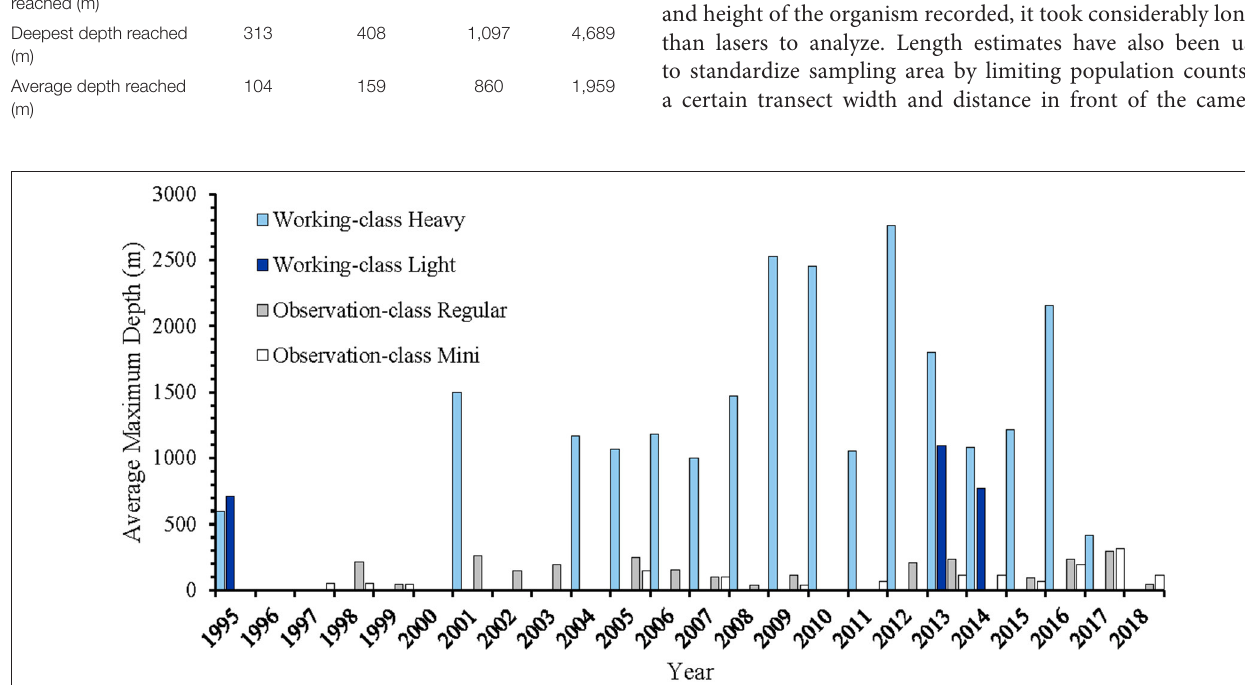
FIGURE 4 | Temporal trends in the average maximum depth (m) surveyed using mini-sized observation-class (white), regular-sized observation-class (Light Gray), light working-class (Dark Blue), and heavy working-Class (Light Blue) ROV systems.